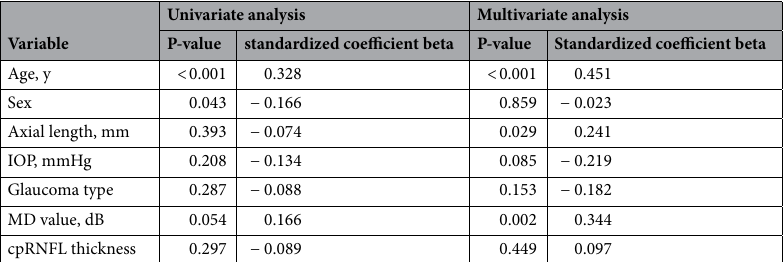
Table 2. Linear regression analysis of variables associated with the area of parapapillary beta zone in the whole study group. All the univariate variables in the table are included in the multivariate analysis. MD: mean deviation; RNFL: retinal nerve fiber layer; IOP: intraocular pressure.